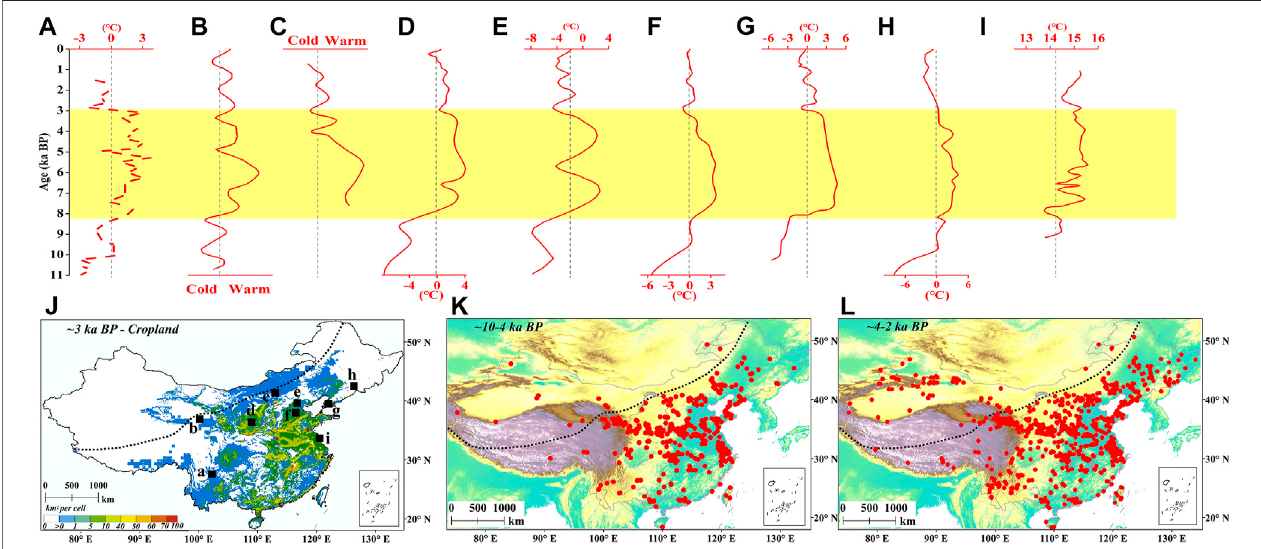
FIGURE 1 | (A – I) , Pollen-based Holocene temperature records from monsoonal humid China which support a mid-Holocene Megathermal and a long-term cooling trend during the late Holocene (Shi et al., 1994). (J) , Spatial distribution of the pollen-based Holocene temperature records shown in the upper column (representedbythesamecodes).Thedashedblacklinerepresentsthemodernmonsoonallimit(Chenetal.,2008),andthebackgroundcolorsrepresenttheproportion ofcultivatedlandsat~3ka(LiF.etal.,2020). (K,L) ,SpatialdistributionofChinesearchaeologicalsitesfortheintervalsof~10 – 4kaand~4 – 2ka,respectively(Dong et al., 2020).